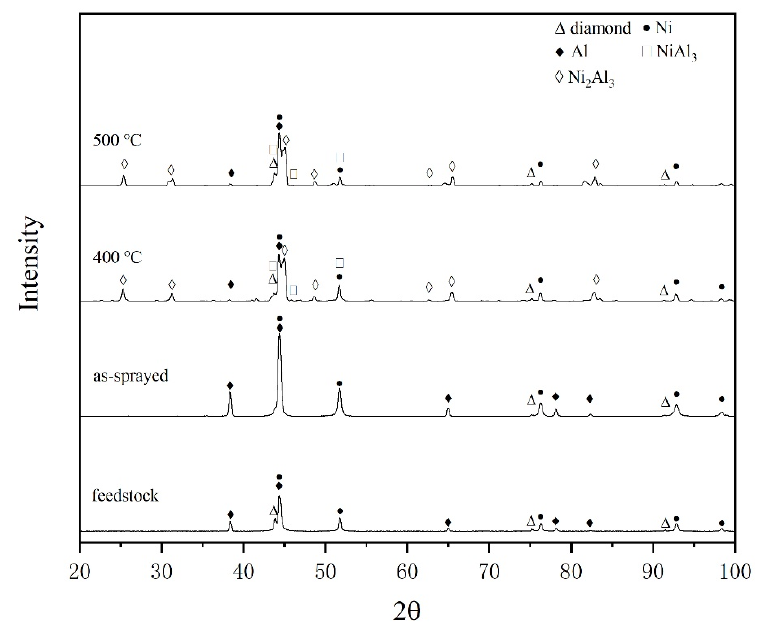
Figure 5. XRD patterns of feedstock, as-sprayed coating, heat-treated coatings at 400 °C and 500 °C.